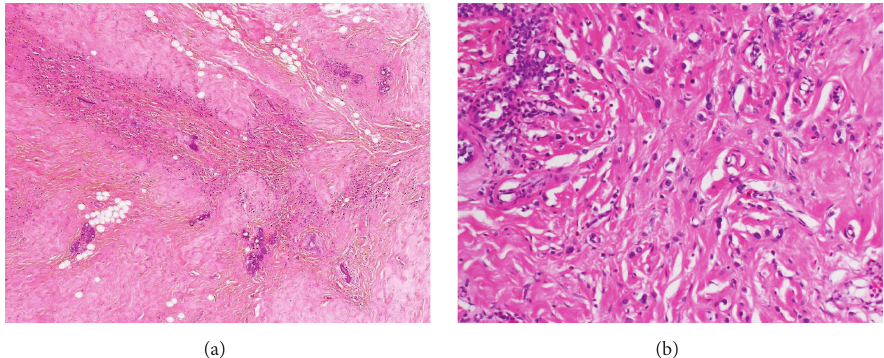
Figure 1: Histological analysis of the left breast. The initial diagnosis was scirrhous carcinoma, because the tumor cells were associated with a dense connective tissue in the stroma. The diagnosis was later revised to invasive lobular carcinoma.